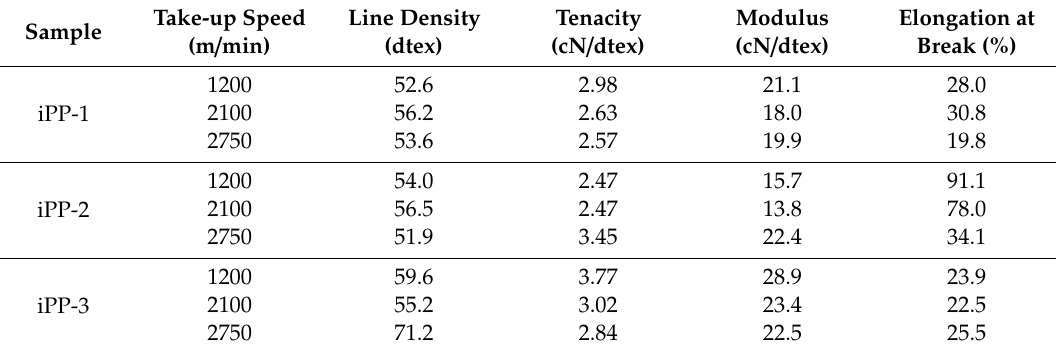
Table 7. The tensile properties of drawn iPP fibers (draw ratio: 1.6).